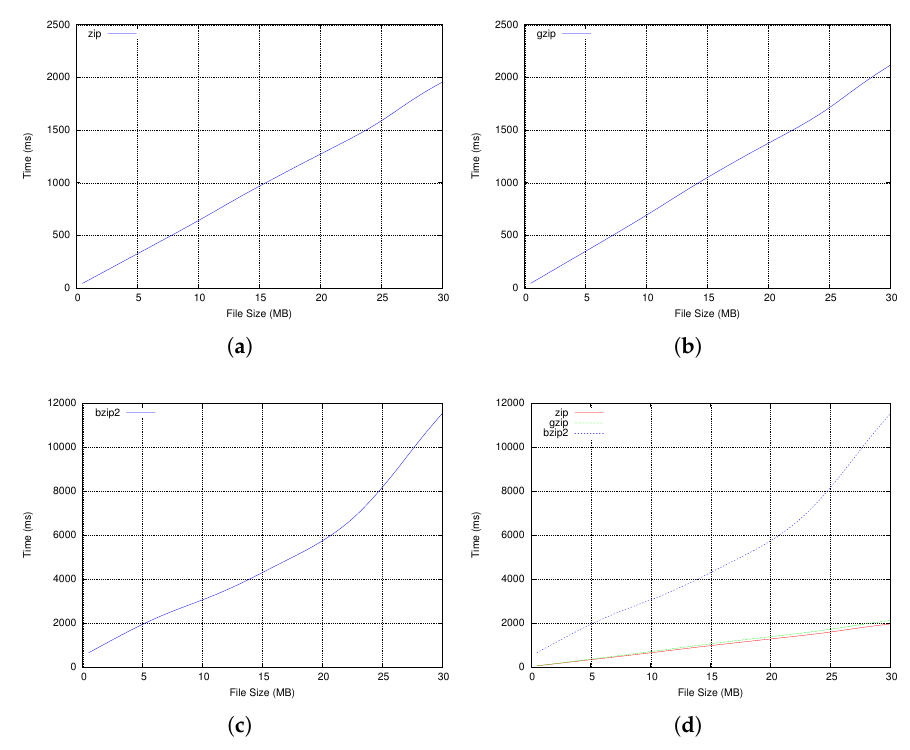
Figure 7. Time requirement for SH-VARR snapshot based on three compression algorithms. ( a ) Using zip algorithm; ( b ) Using gzip algorithm; ( c ) Using bzip2 algorithm; ( d ) All